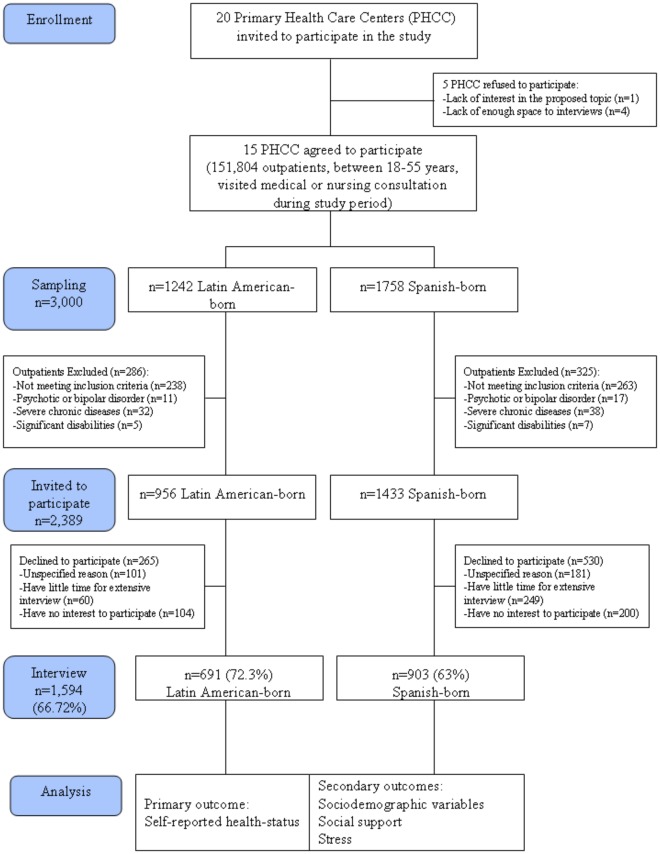
Flow diagram of participants.